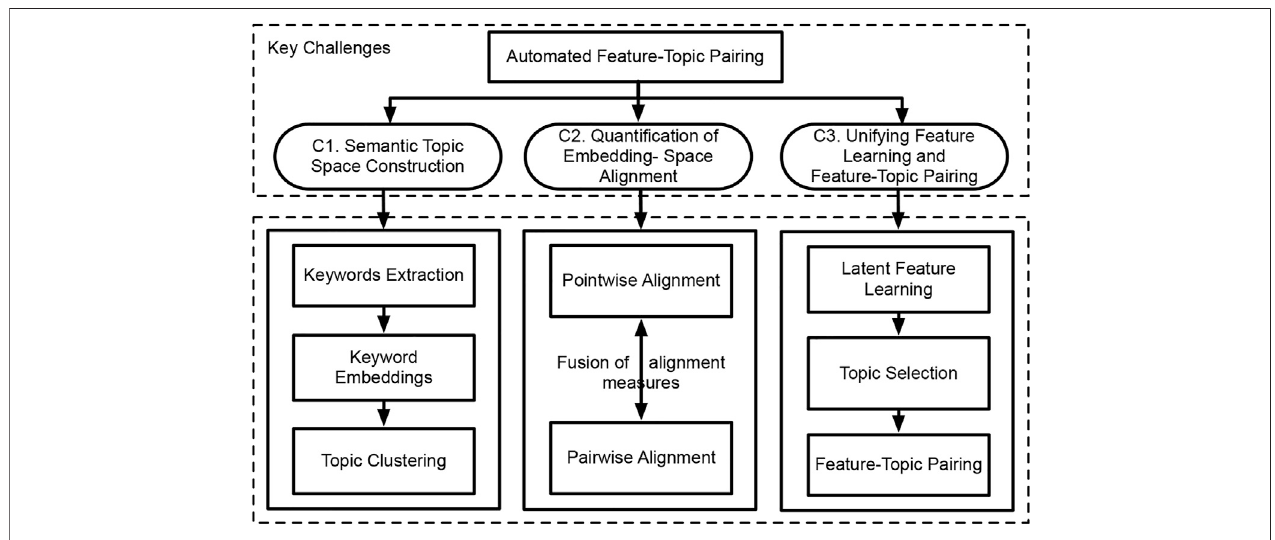
FIGURE 2 | Key challenges and main tasks of the feature-topic pairing